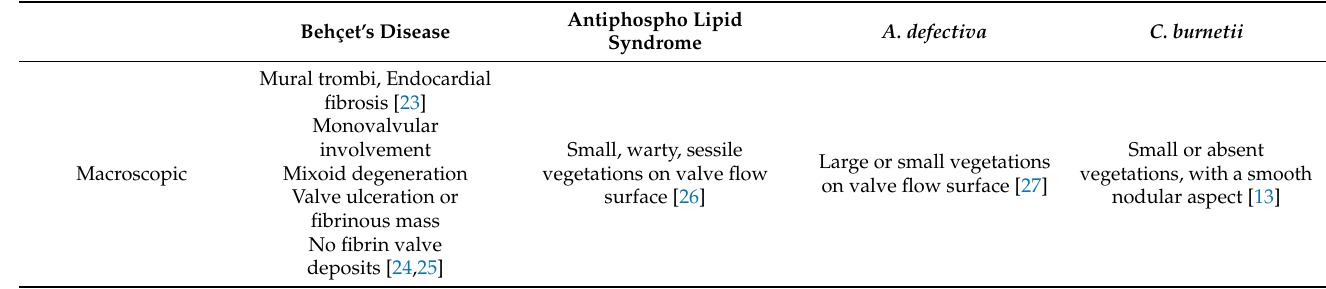
Table 1. Comparative valve pathology in BD, APL, A. defectiva and C. burnetii . Behçet’s